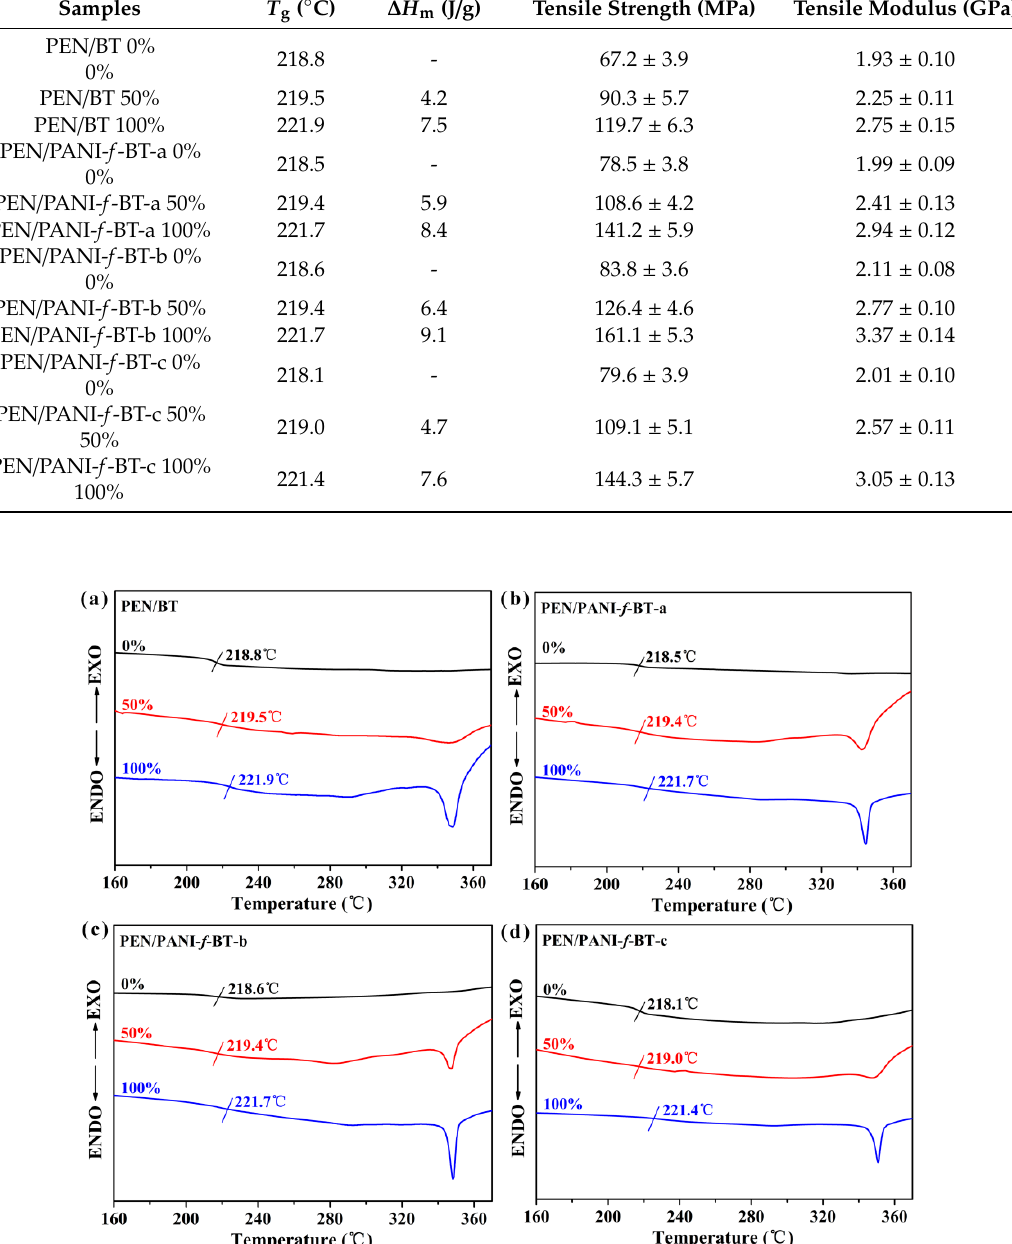
Figure 7. The wide-angle XRD patterns of PEN/PANI- f -BT-b at different stretching ratios. 3.4. Mechanical Properties of PEN/PANI-f-BT Composites Resulting from the improved compatibility and crystalline of the composite, their enhanced properties are further investigated. Tensile strength and tensile modulus, two most important mechanical properties of the high-performance engineering plastics, are typically studied. The tensile properties of the PEN-based nanocomposites at different stretching ratios are shown in Figure 8. The